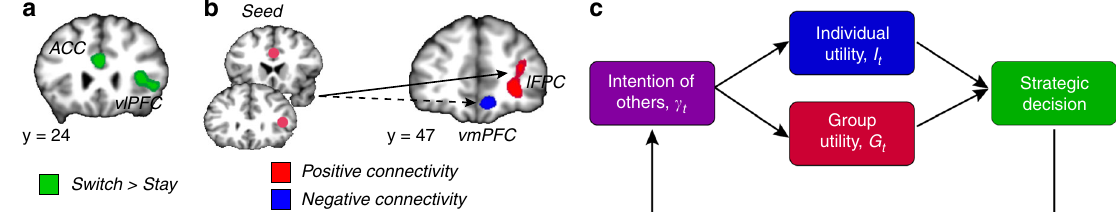
Fig. 5 Neural mechanisms of strategy selection during the public goods game (PGG). a Activity in the right ventrolateral prefrontal cortex (vlPFC) and the anterior cingulate gyrus (ACCg) increased when switching one ’ s decision during the PGG. The statistical maps are thresholded with the same convention as in Fig. 3. b Connectivity analyses between the brain regions engaged in switching to the alternative strategy (the vlPFC and the ACC) and the brain areas encoding the individual utility and the group utility. The circles represent seed regions from which physiological signals were extracted, and colored blobs show the psychophysiological interaction effect. The ventromedial prefrontal cortex (vmPFC; blue), encoding the individual utility, shows a negative correlation with the activity in seed regions modulated by the probability to change one ’ s strategy to contribution Δ Q ( Δ Q = Q t − Q t − 1 ), predicted by the social learning model ( p < 0.05 small-volume corrected). The right lateral frontopolar cortex (rlFPC; red), which encoded the group utility, shows a positive correlation with the signals in seed regions modulated by Δ Q ( p < 0.05 small-volume corrected). c Scheme of the social learning model that predicts strategic decisions during PGG. In this model, participants estimate the utility of strategies with the immediate individual utility, I t and the group utility, G t used for a long-term strategy based on their belief about the decision of others ( γ t and 1 − γ t ). The weighted sum of I t and G t is then integrated into a strategic decision, Q t ,. When the outcome is revealed, the belief about the decision of others ( γ t ) is updated with the social prediction error and the reward prediction